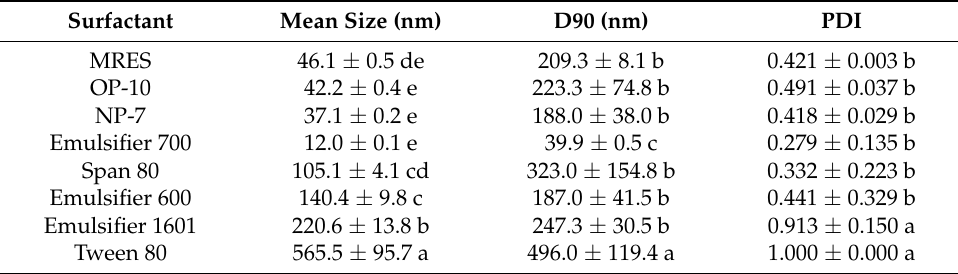
Table 1. The effect of single surfactant on particle size and PDI of LCNS.